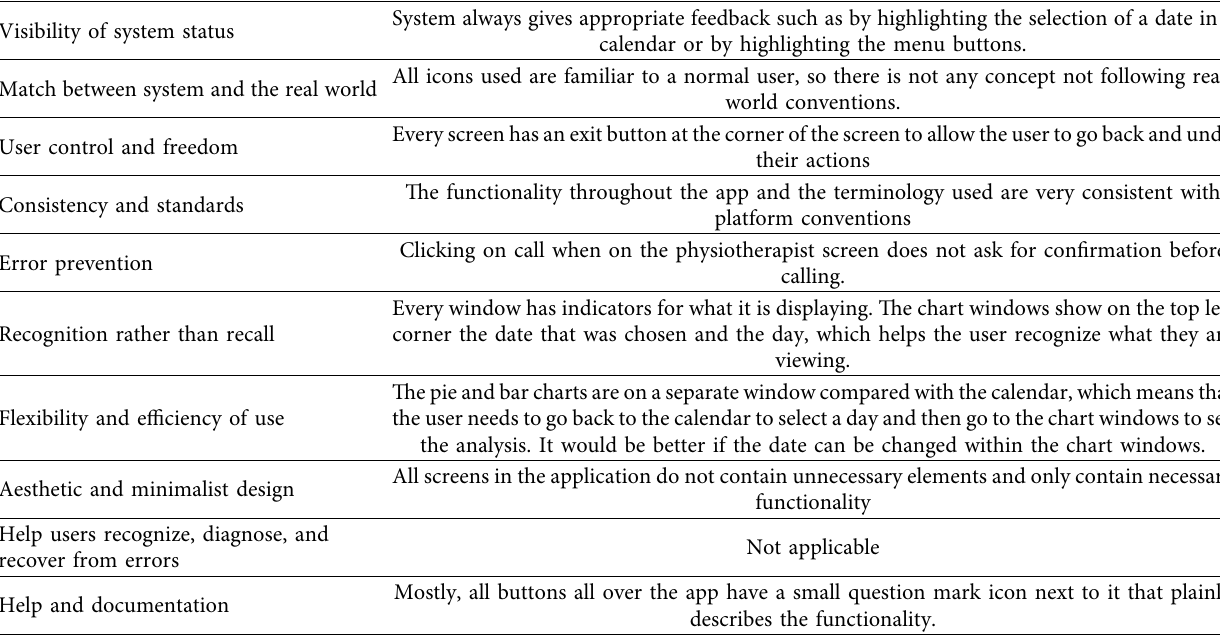
Table 3: Visualization of the heuristic evaluation using 10 heuristic usability principles. System always gives appropriate feedback such as by highlighting the selection of a date in a Visibility of system status calendar or by highlighting the menu